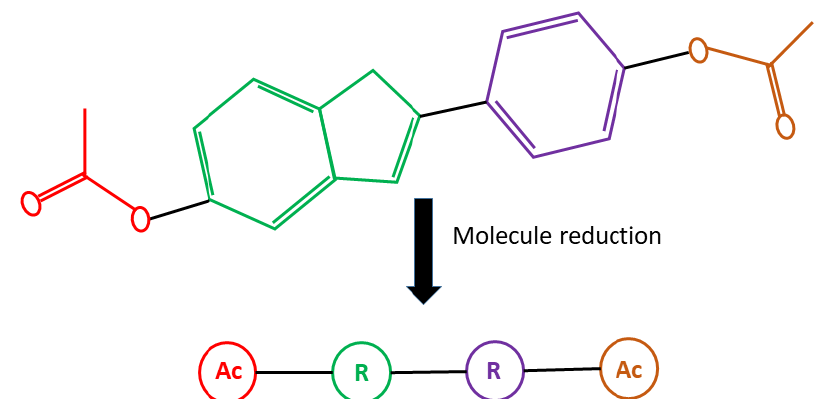
Figure 1. Example of molecule reduction using ErG. The original molecule is on the top and its ErG representation is below. Elements of the same colour on the top are reduced to nodes on the ErG. R: Ring system, Ac: Acyclic